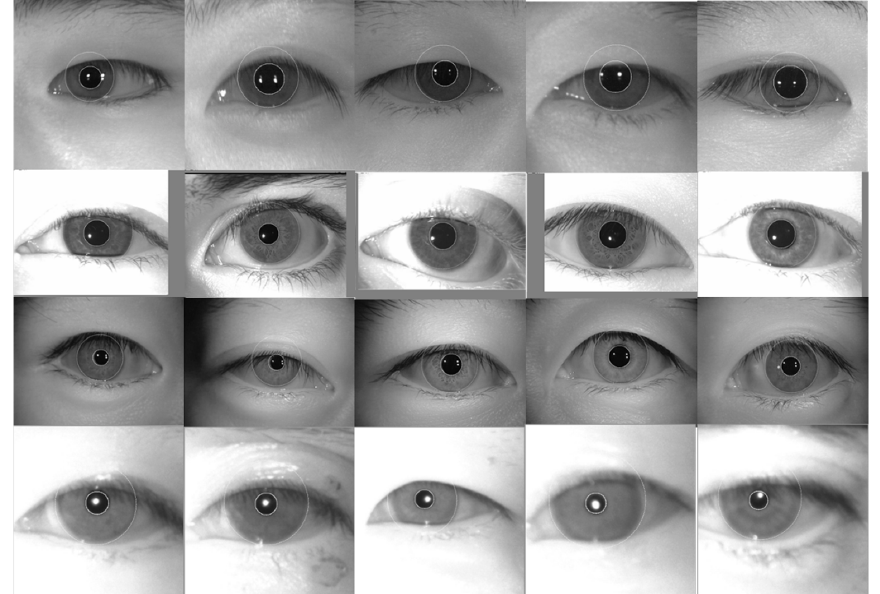
Figure 5. Typical iris localization results obtained using the proposed method on the CASIA.v4- distance, ND-LG4000, CASIA.v4-lamp, and CASIA-M1-S2